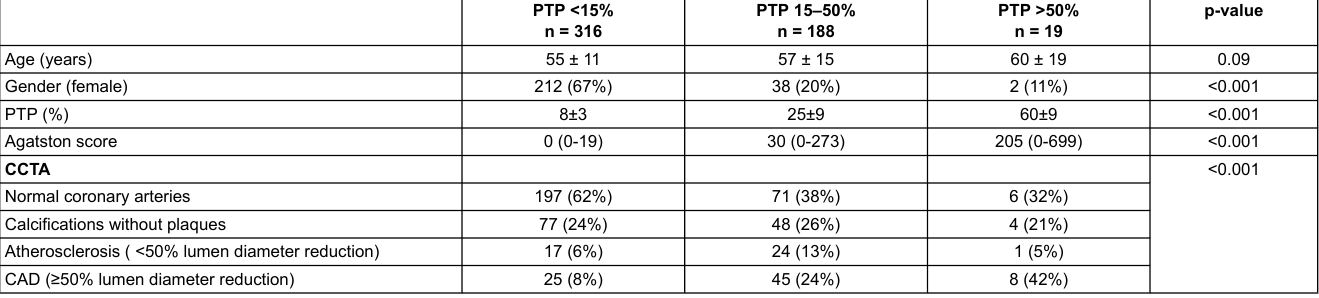
Table 1: Characteristics of the entire study group (n = 523) according to the three pretest probability (PTP)